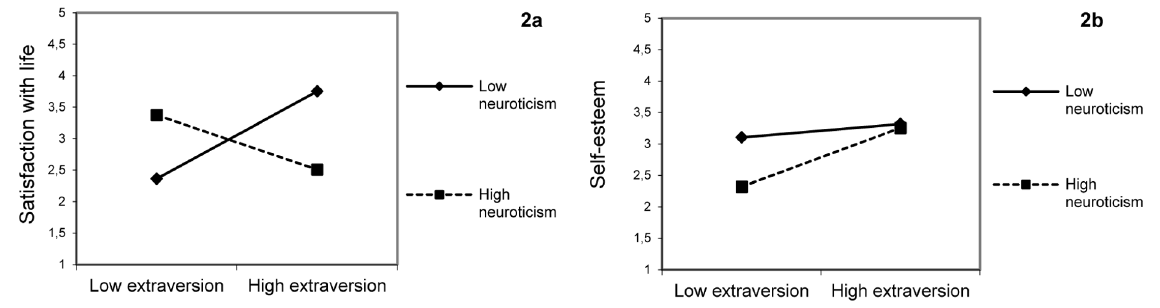
Figure 2. Two-way interaction